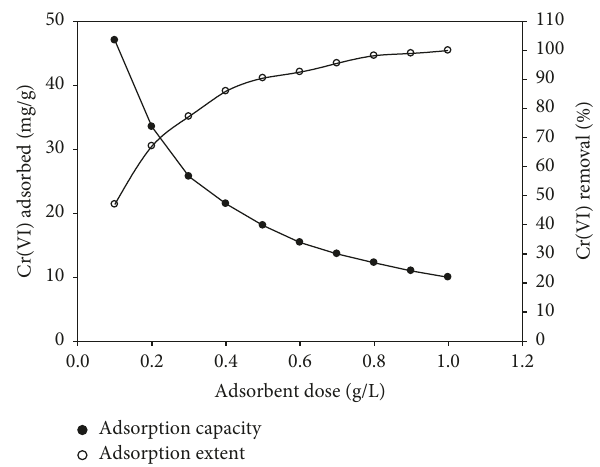
Figure 4: Effect of biosorbent mass on the biosorption of Cr(VI) ions onto biopolymer at pH 7 concentration